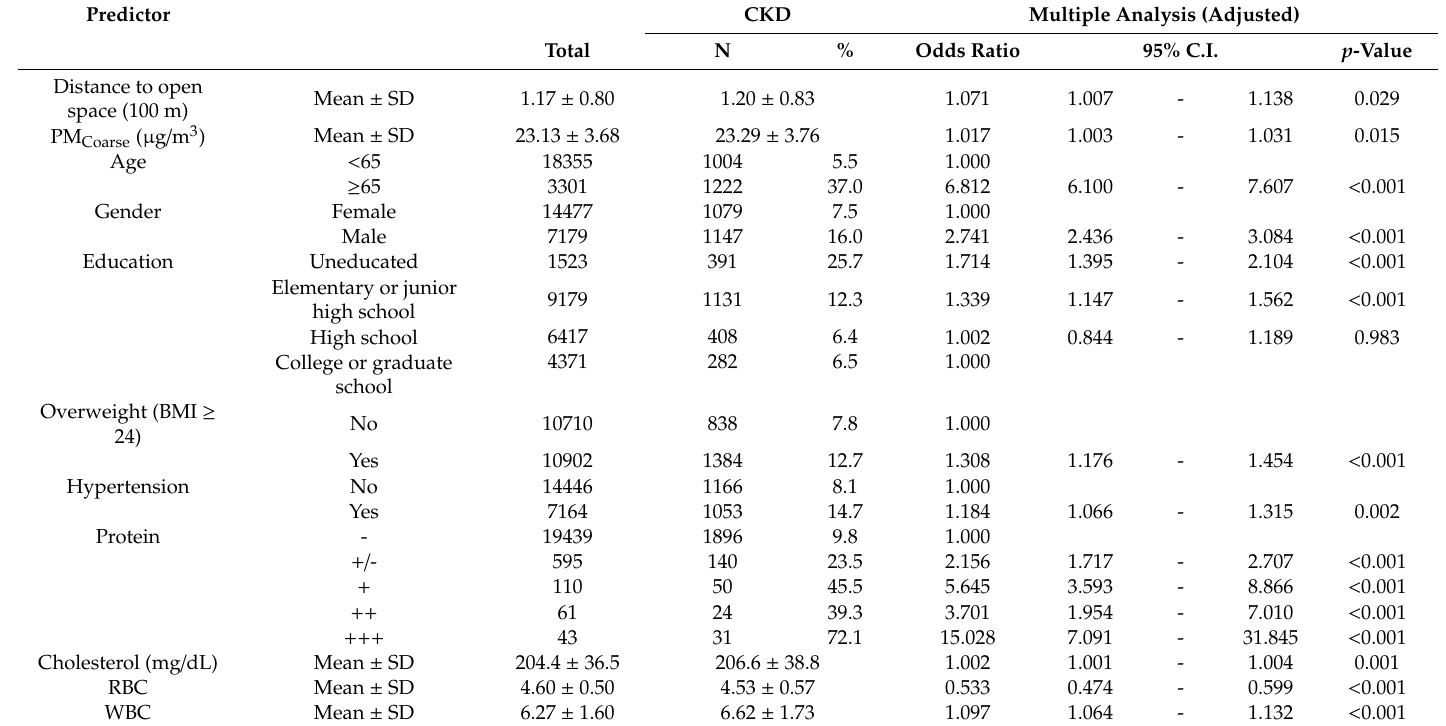
Table 3. Odds ratio for